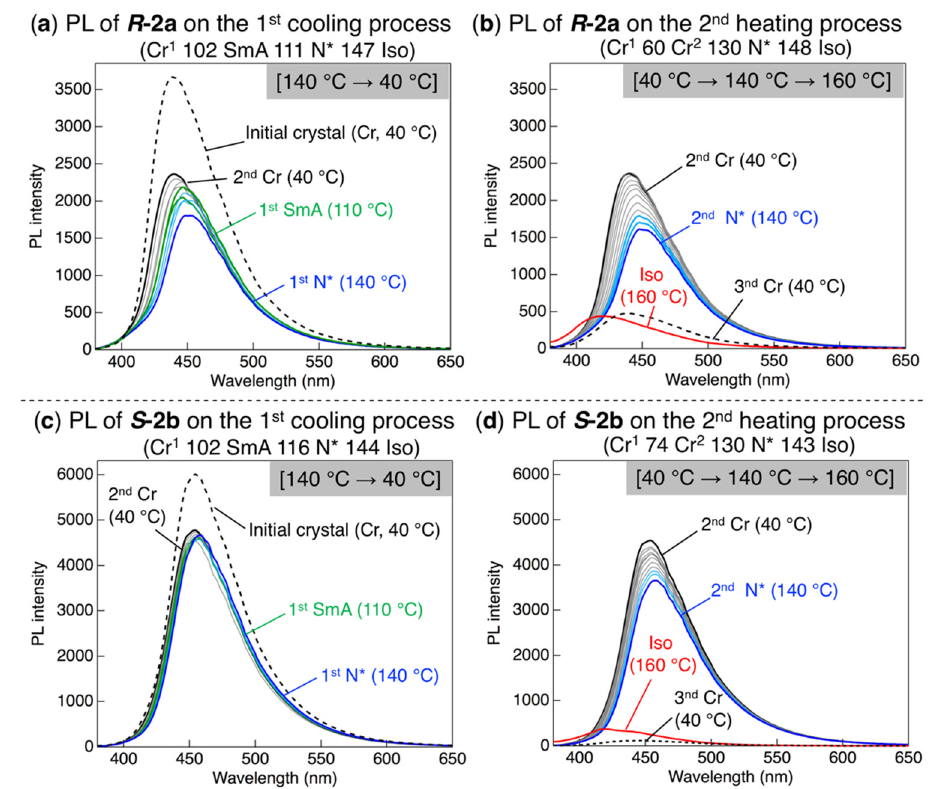
Figure 8. PL behavior of R -2a ( λ ex = 365 nm) on the ( a ) first and ( b ) second heating and cooling processes. PL behavior of S -2b ( λ ex = 365 nm) on the ( c ) first and ( d ) second heating and cooling processes. Colors, black: Cr; green: SmA; blue: N*; red: Iso phases.